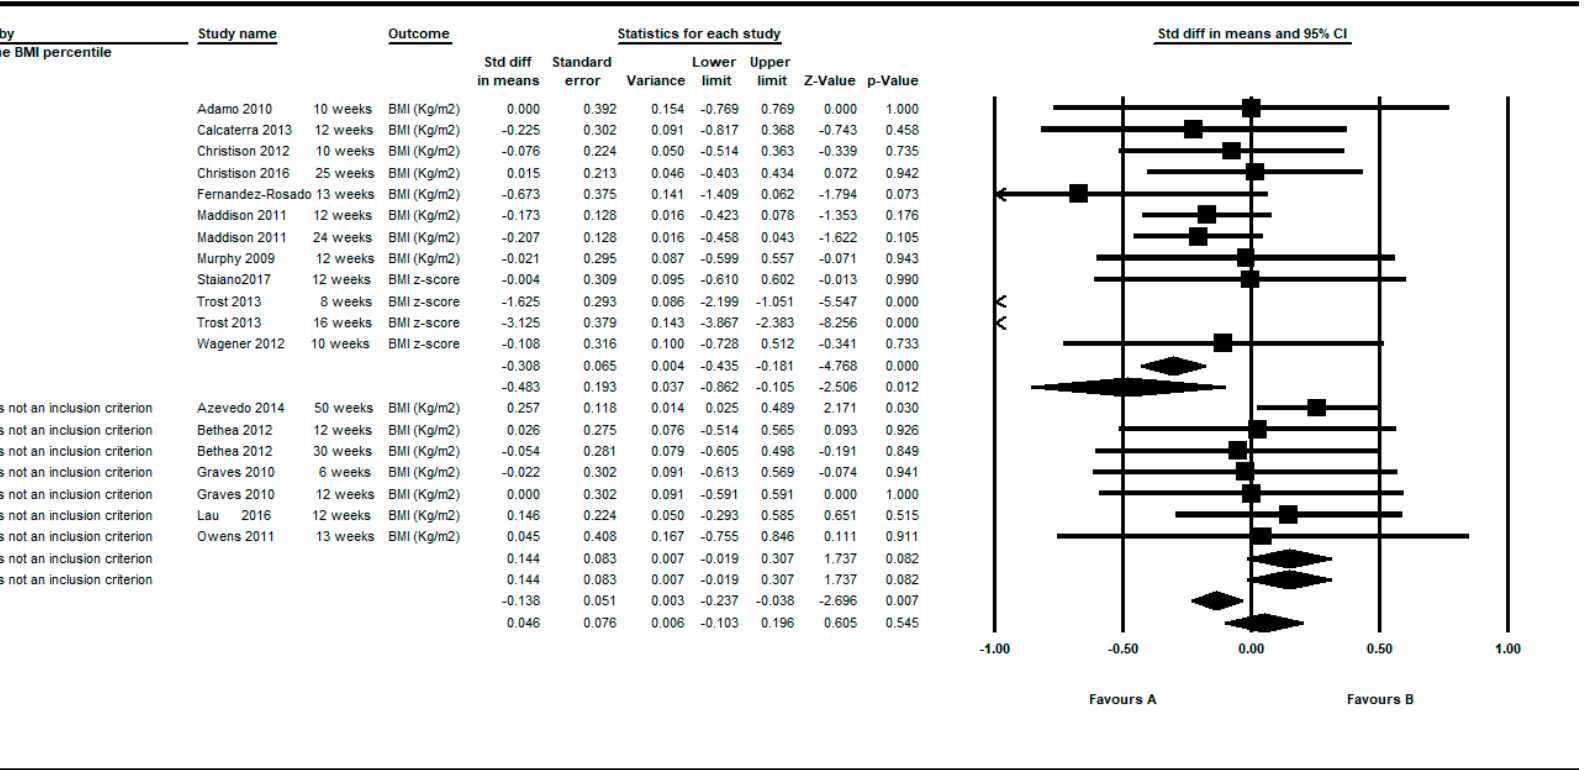
Figure 18. Pre-post intra-group difference in BMI in the group intervened with active video games. Subgroup analysis based on baseline BMI ( ≥ 85 vs. BMI was not an inclusion criterion).